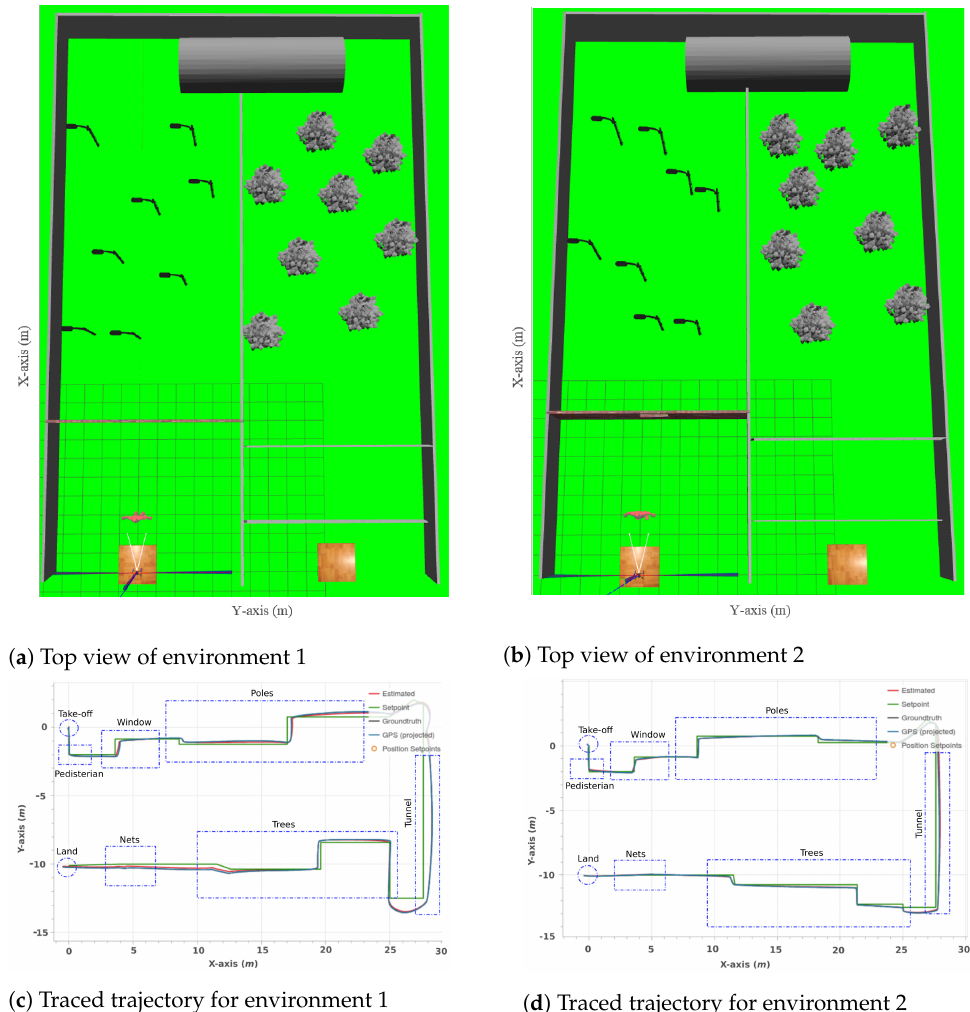
Figure 7. Top views of two simulation environments and traced